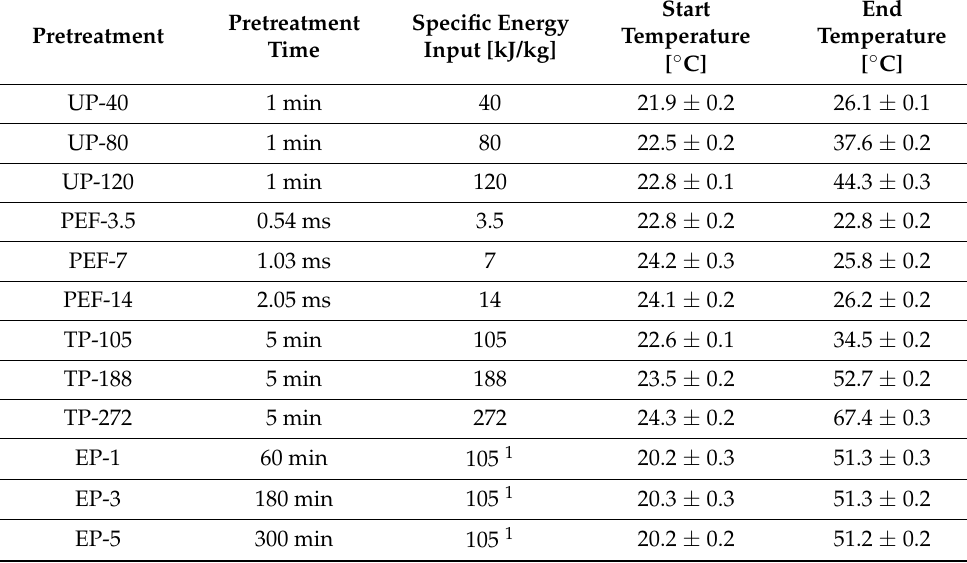
Table 1. Treatment time, specific energy input [kJ/kg], start and end temperature [ ◦ C] of